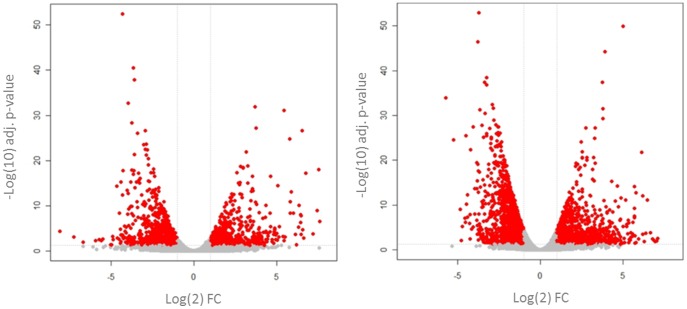
Transcriptional changes in the human and rat UVB model.Volcano plots compare the transcriptional FC (x-axis) versus their level of significance (y-axis). In humans (A) and in rats (B) many genes were significantly dysregulated 48 hours after irradiation in UVB treated skin compared to control. Those genes highlighted in red represent genes which were both statistically significant and at least 2 fold dysregulated in comparison to control. It should be noted that p values are shown on a −log10 scale and FC values on a log 2 scale. FC = UVB/control, human n = 5 irradiated, n = 4 non-irradiated, rat n = 6. Adjusted p-values calculated with FDR.